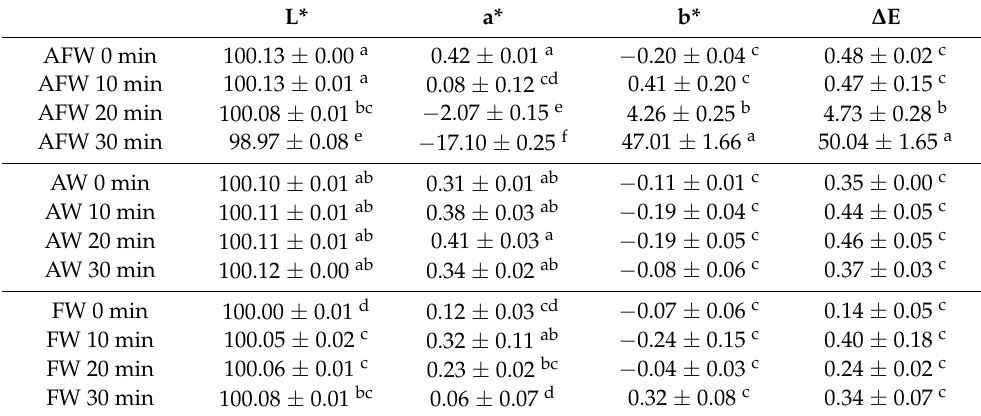
Table 1. Chromatic parameters of solutions containing a combination of asparagine and fructose during 0–30 min of heating in water.